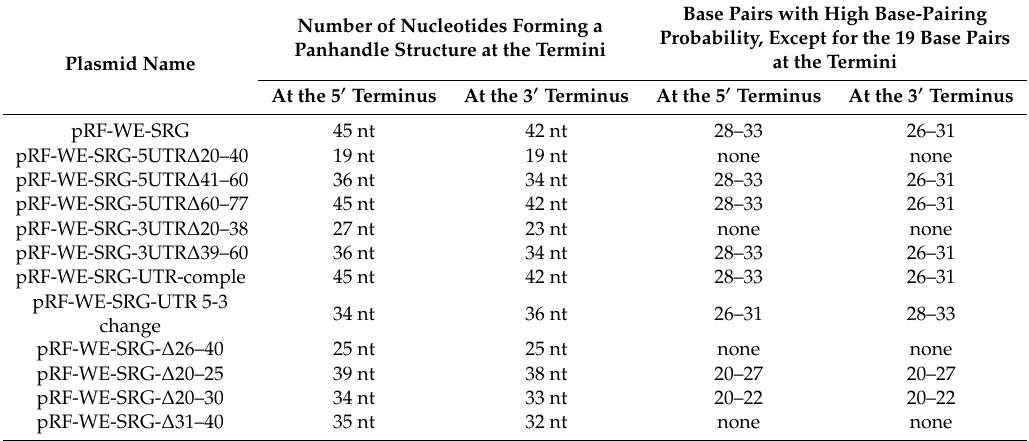
Figure 2. Prediction of RNA secondary structures of LCMV strain WE (LCMV-WE) S segment UTR: The predicted RNA secondary structure of LCMV-WE S segment UTR derived from pRF-WE-SRG. The location of the 19 base pairs in the termini and the base pairs comprising the 28th–33rd nt in the 5 ′ terminus and the 26th–31st nt in the 3 ′ terminus are shown. RNA sequences of LCMV-WE S segment genome 5 ′ -terminal and 3 ′ -terminal UTRs and 50 nt of open reading frame (ORF) regional RNA sequences that were directly downstream of the UTRs were linked, sent to the CENTROIDFOLD server, and analyzed using the CONTRAfold model (weight of base pairs: 2 2 ). Each predicted base pair is colored with heat-color gradation from blue to red, corresponding to the base-pairing probability from 0 to 1. The labels “5” and “3” indicate RNA 5 ′ and 3 ′ termini, respectively. Table 3. RNA secondary structure prediction of the LCMV S segment RNA produced from each plasmid.